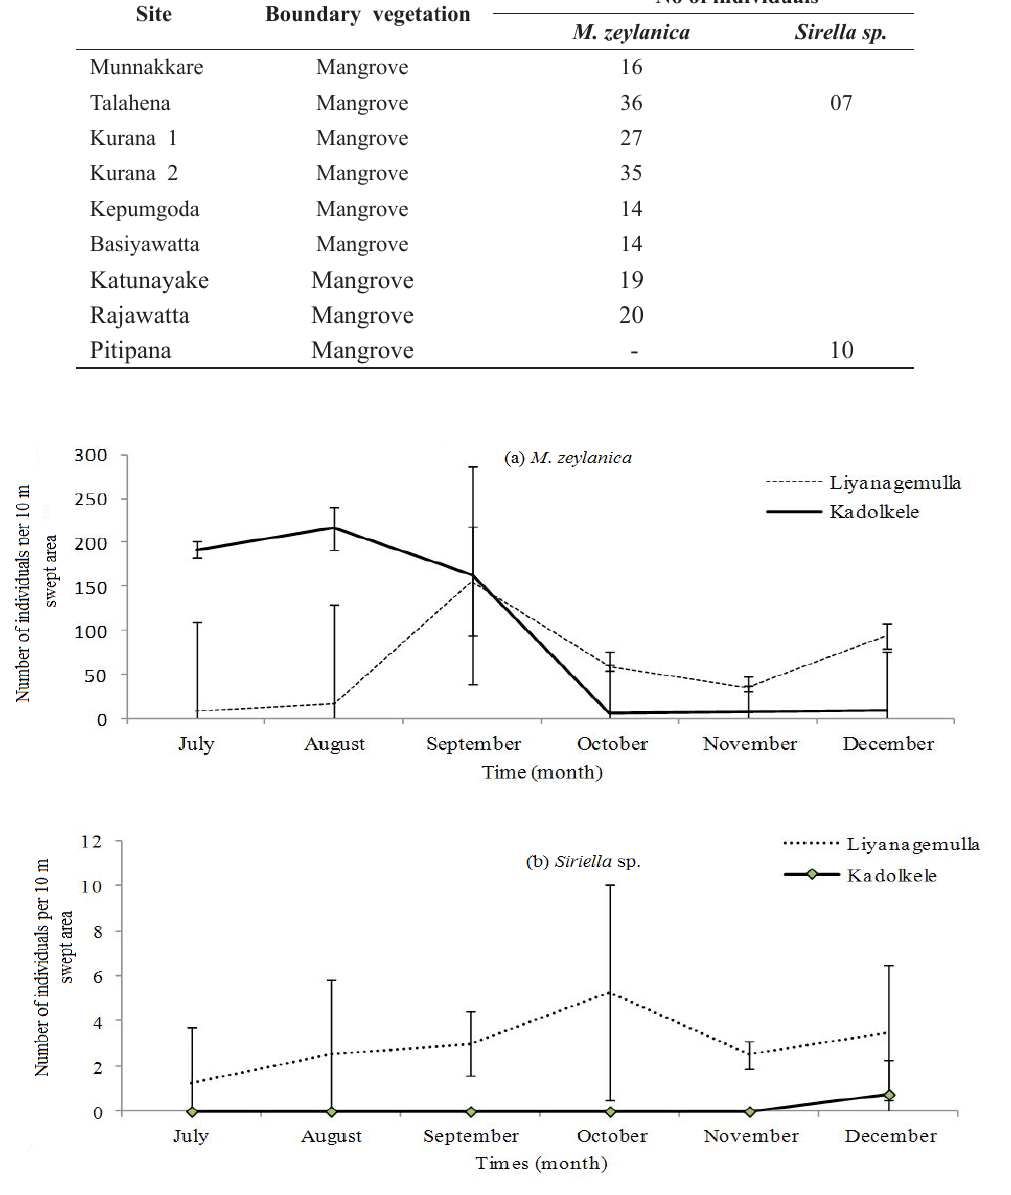
Figure 2: Monthly variation of mean (± SD) abundance (n = 4) of mysid species, (a) M . zeylanica (b) Siriella sp. in Negombo